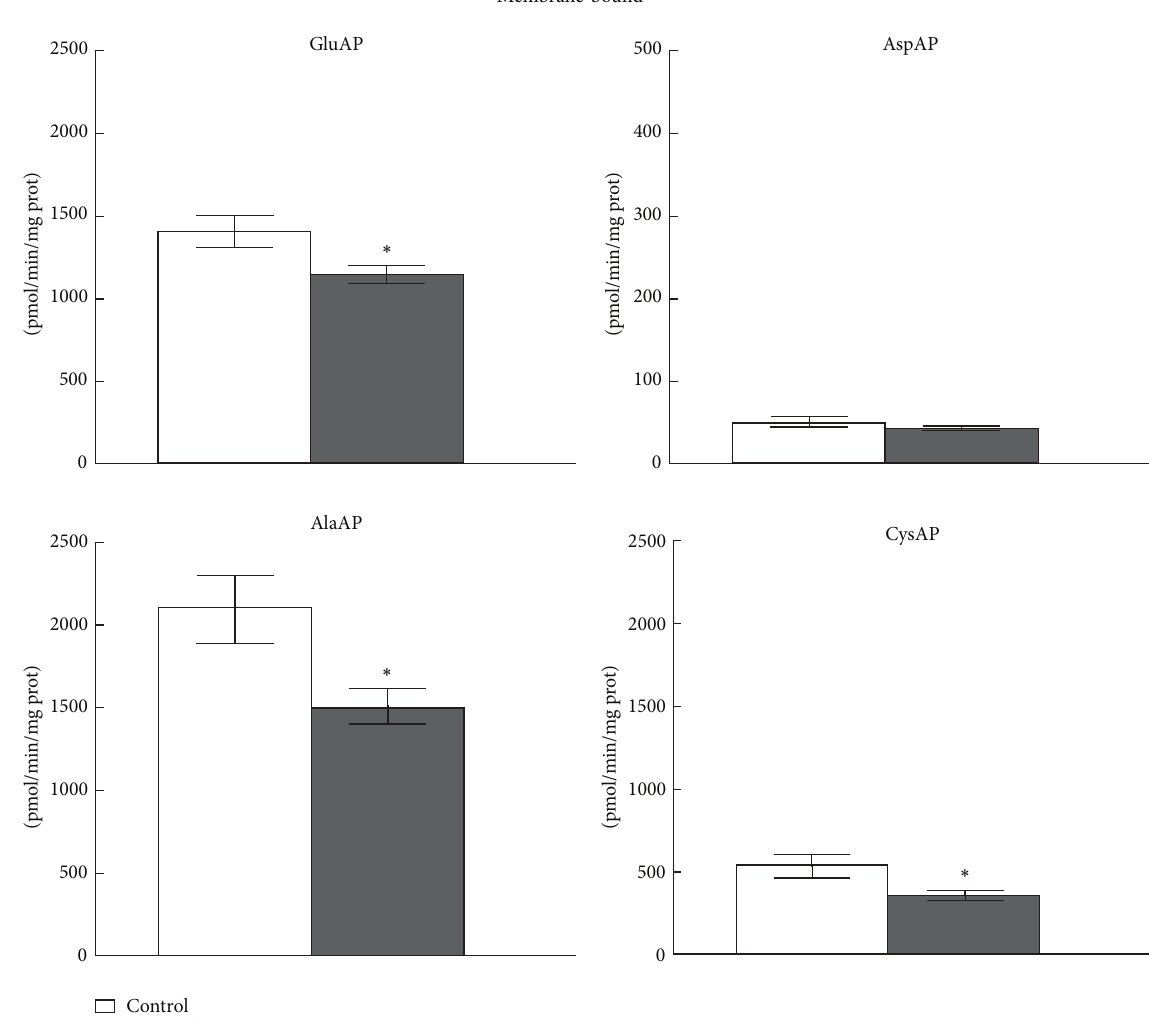
Figure 3: Membrane-bound GluAP, AspAP, AlaAP, and CysAP activities in the left ventricle of control ( 𝑛 = 10 ) and captopril-treated ( 𝑛 = 10 ) spontaneously hypertensive rats. The values represent the mean ± SEM of specific GluAP, AspAP, AlaAP, and CysAP activities expressed as picomoles of glutamyl-, aspartyl-, alanyl-, or cystinyl- 𝛽 -naphthylamide hydrolyzed per min per mg of protein. ∗ 𝑃 < 0.05